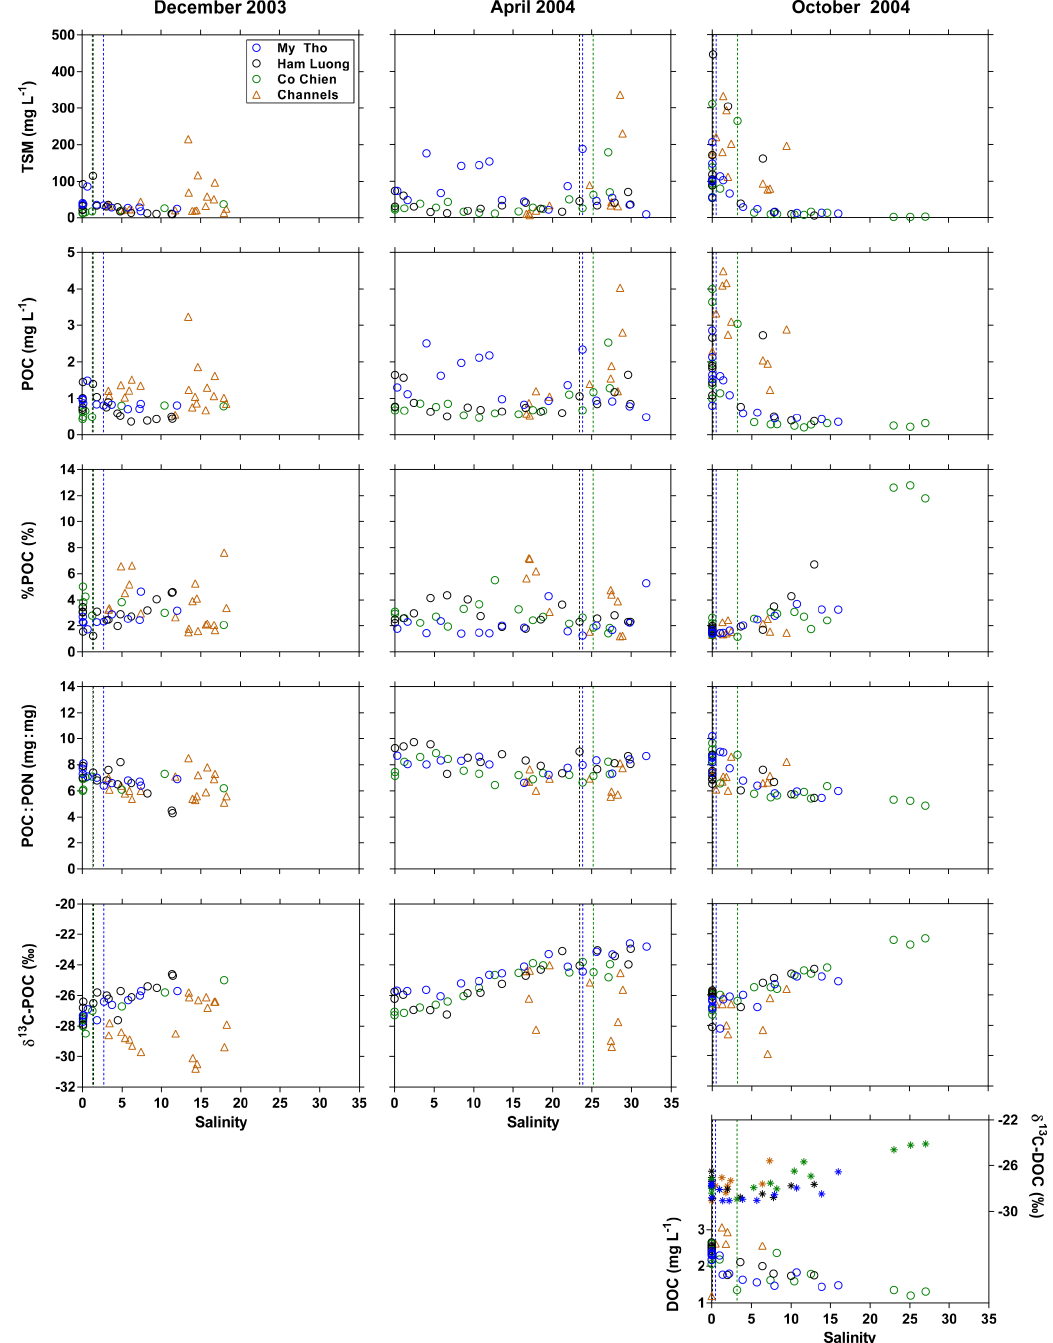
Figure 6. Distribution as a function of salinity of the partial pressure of CO 2 (pCO 2 , ppm), oxygen saturation level (%O 2 , %), total alkalinity (TA, µmol kg − 1 ) , dissolved inorganic carbon (DIC, µmolkg − 1 ) , stable isotope composition of DIC ( δ 13 C-DIC, ‰), dissolved CH 4 concen- tration (nmolL − 1 ) , total suspended matter (TSM, mgL − 1 ) , particulate organic carbon (POC, mg L − 1 ) , percent of POC in TSM (%POC, %), POC-to-particulate nitrogen ratio (POC:PN, mg:mg), stable isotope composition of POC ( δ 13 C-POC, ‰), dissolved organic carbon (DOC, mgL − 1 ) , and stable isotope composition of DOC ( δ 13 C-DOC, ‰) in the three branches of the Mekong delta (M e y Tho, Hàm Luông, and C ´ˆ o Chiên) and side channels in December 2003, April 2004, and October 2004. The vertical dotted lines indicate the location of the river mouths. Horizontal dotted lines indicate the CO 2 and O 2 atmospheric